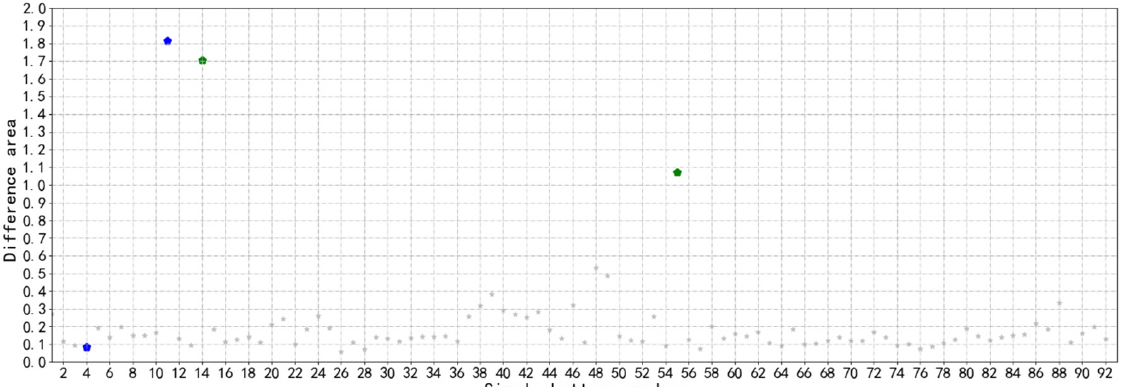
Figure 9. Differential area of single battery voltage.